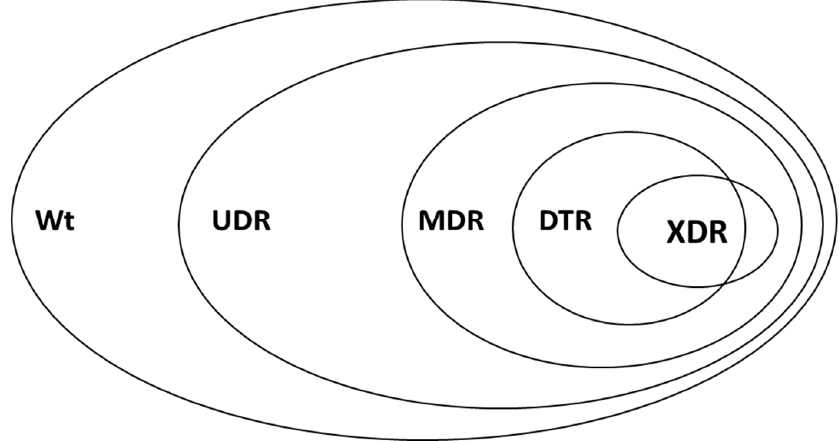
Figure 2. Visual representation of the relationship of various resistance-categories used in this study Wt: wild-type/susceptible; UDR: usual drug resistance; MDR: multi-drug resistance; XDR: extensive drug resistance; DTR: difficult-to-treat resistance; PDR: pandrug-resistance.